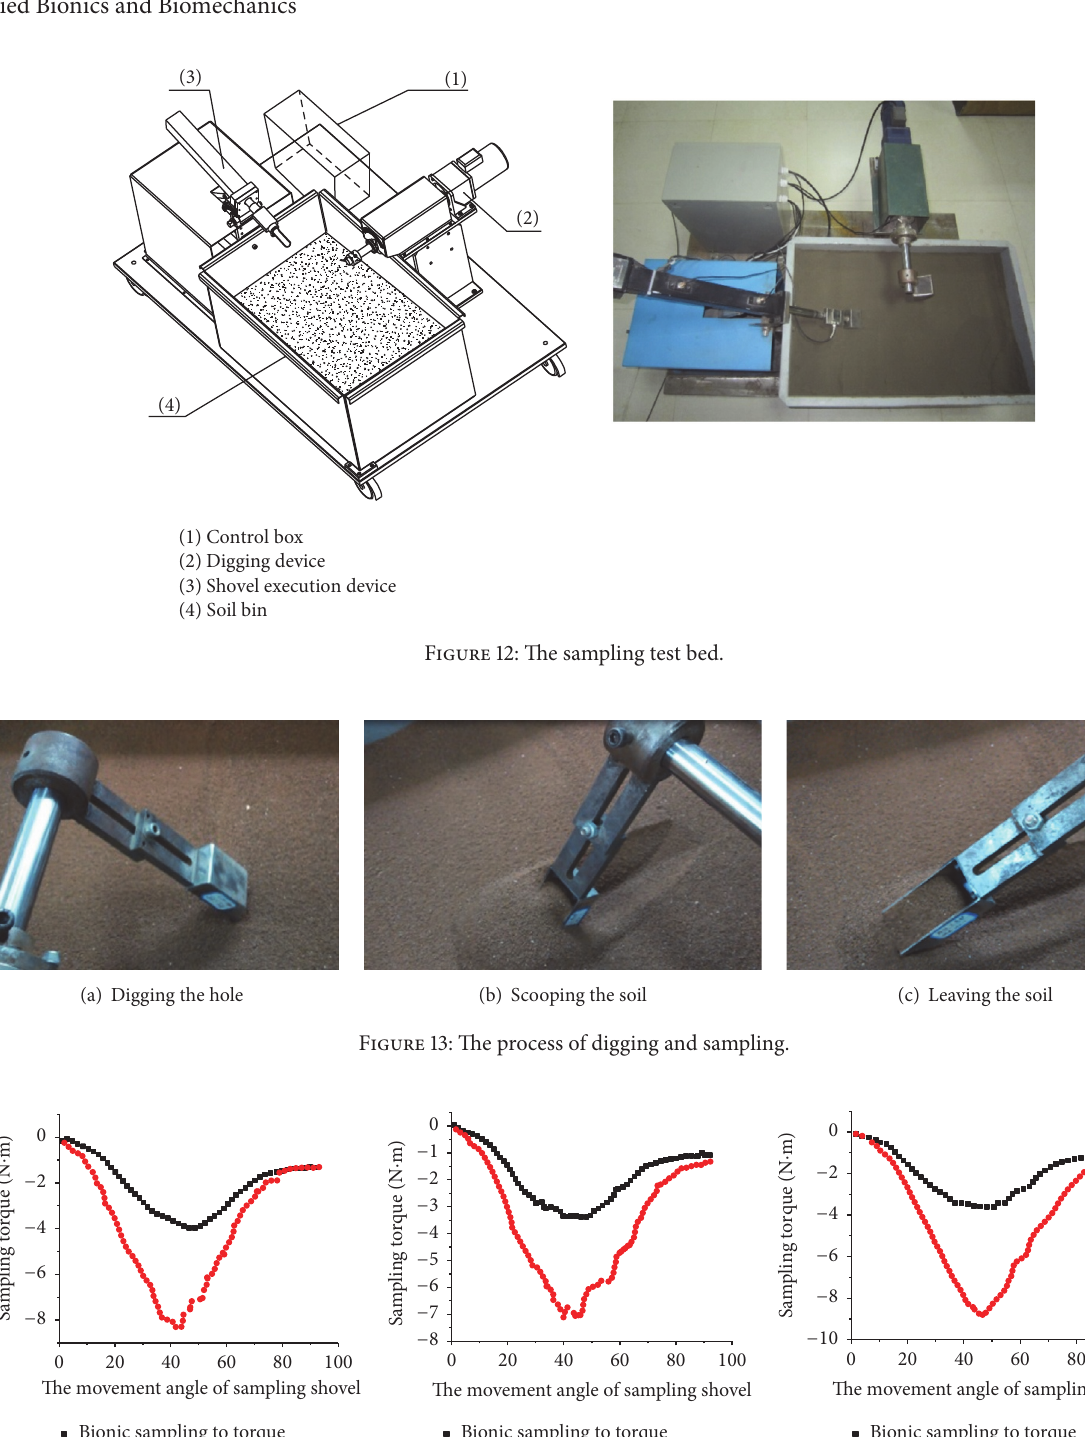
Figure 14: The loading torque of the bionic and prototype sampler at a penetration angle of 45 ∘ .